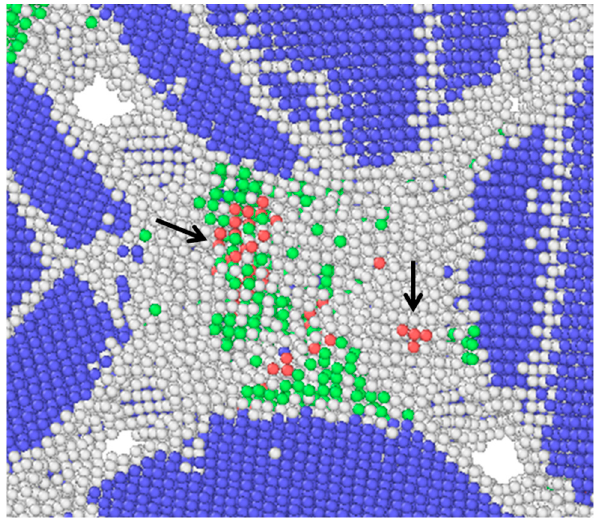
Figure 8. Microstructure after relaxation (FCC, BCC, HCP and unclassified atoms are colored in green, bule, red and white, respectively).